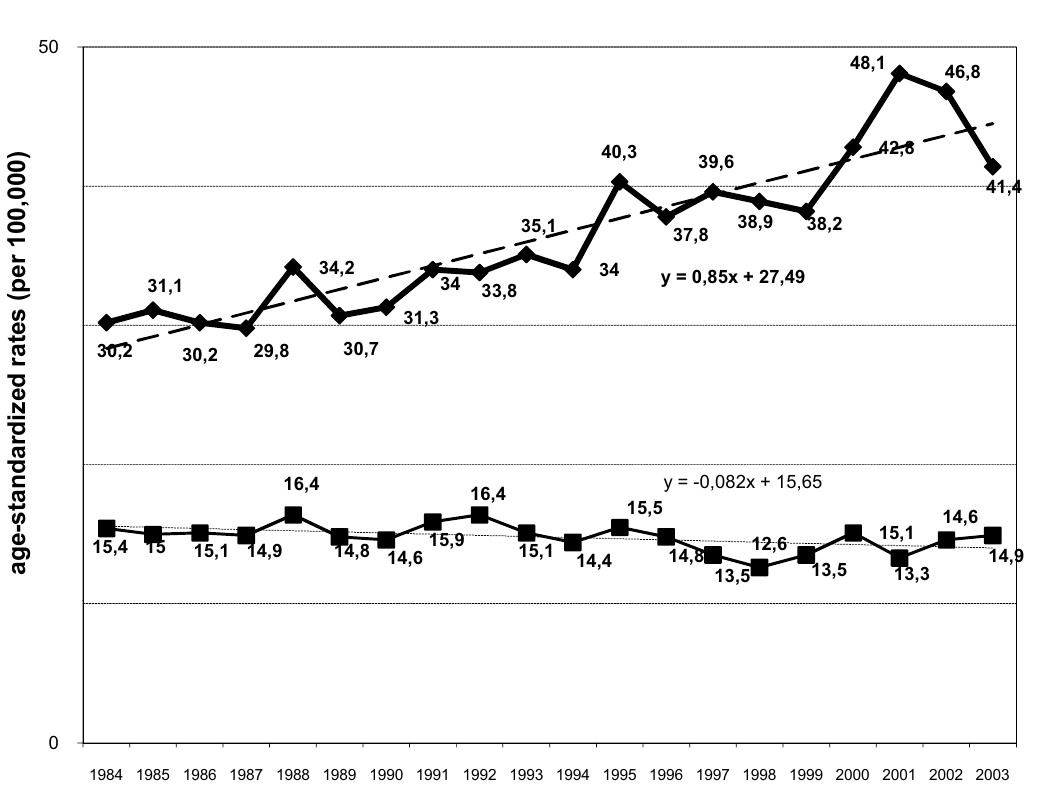
Fig. 2 Age-standardized breast cancer incidence ( (cid:2) ) and mortality ( (cid:3) ) among Lower Silesian women between 1984 and 2003. The trend line were determined by line regression